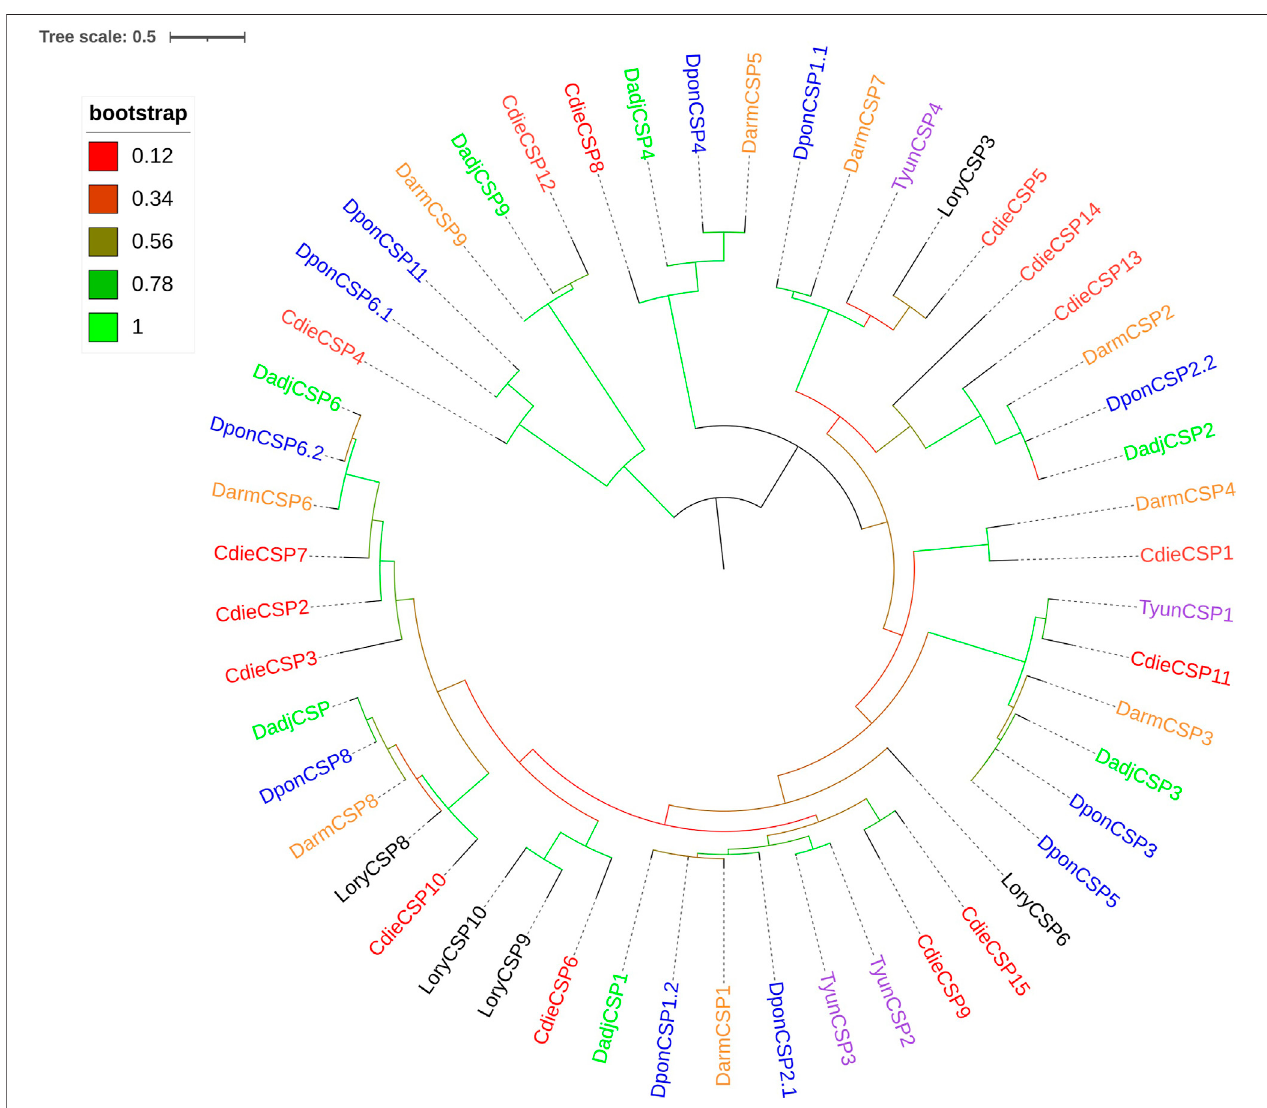
FIGURE 4 | Maximum likelihood tree of CSPs in C. dieckmanni (Cdie, red), Dendroctonus adjunctus (Dadj, green), Dendroctonus armandi (Darm, orange), Lissorhoptrus oryzophilus (Lory, black), Dendroctonus ponderosae (Dpon, blue), and Tomicus yunnanensis (Tyun, purple). The scale bar represents 0.5 amino acid substitutions per